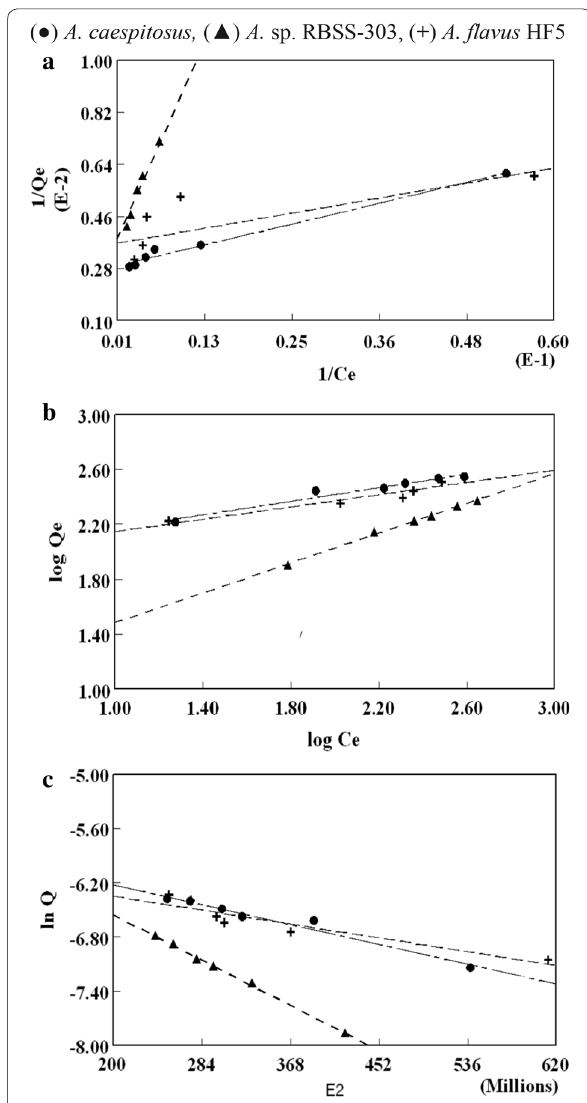
Fig. 5 Langmuir ( a ), Freundlich ( b ) and Dubinin–Radushkevich ( c ) adsorption isotherms plots of Pb(II) biosorption to A. caespitosus, A. sp. RBSS-303 and A. flavus